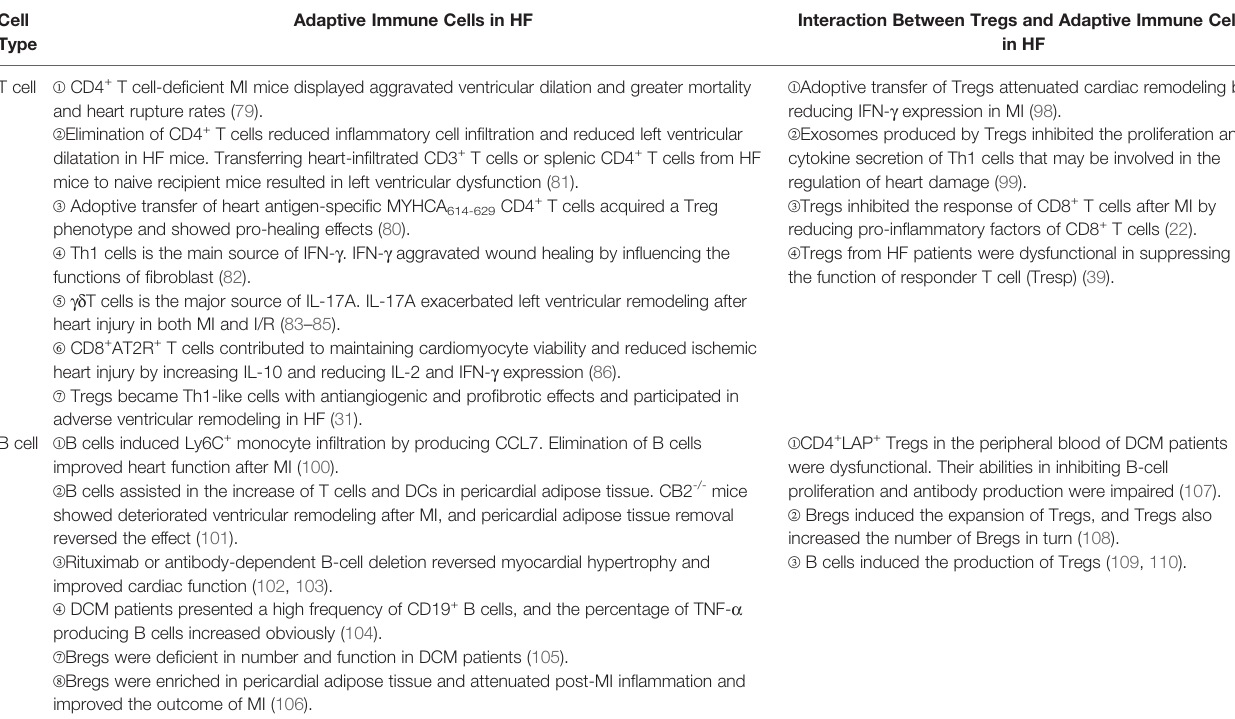
TABLE 2 | The interaction between tregs and adaptive immune cells in